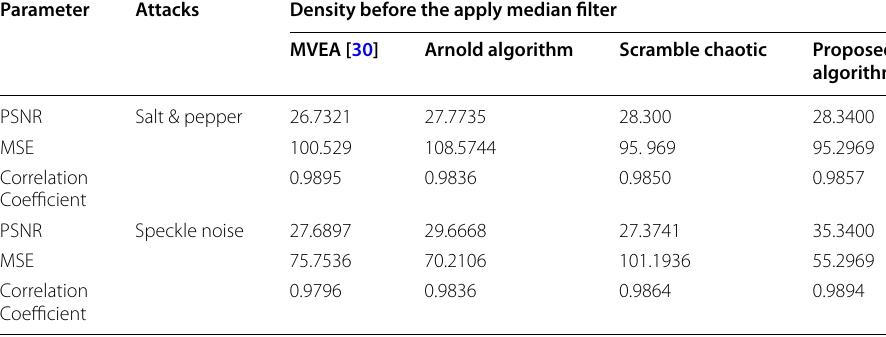
Table 10 Density before applying a median filter Parameter Attacks Density before the apply median filter Arnold algorithm Scramble chaotic